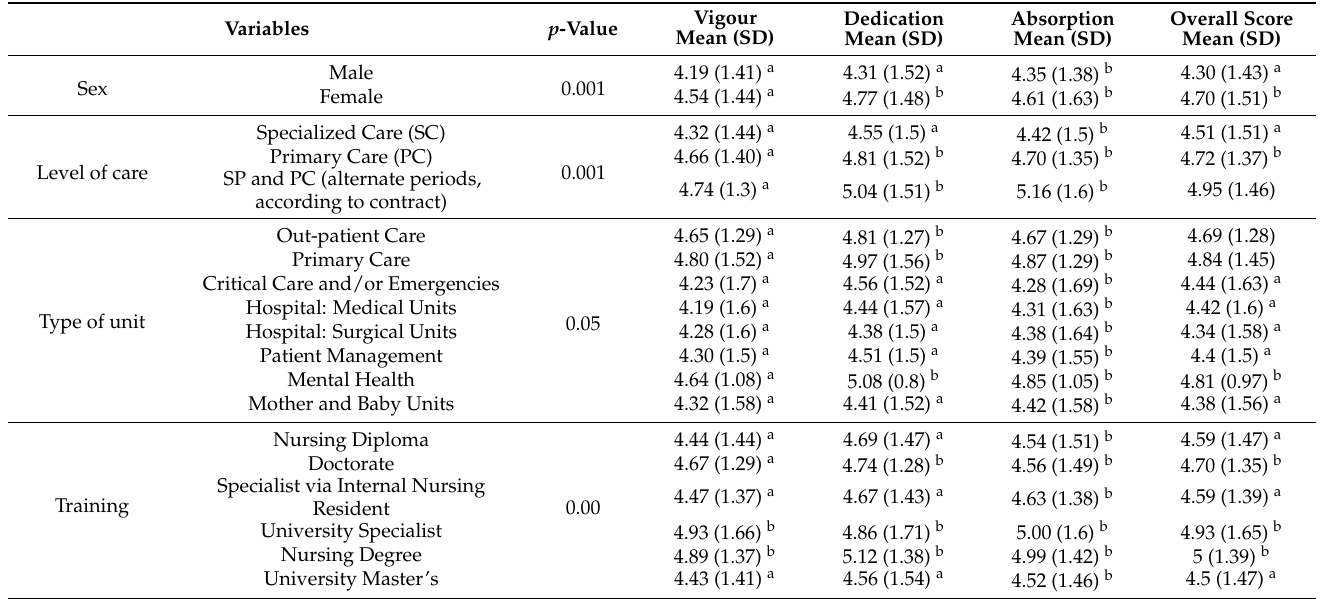
Table 2. Mean scores distribution by UWES-9 dimension and statistical